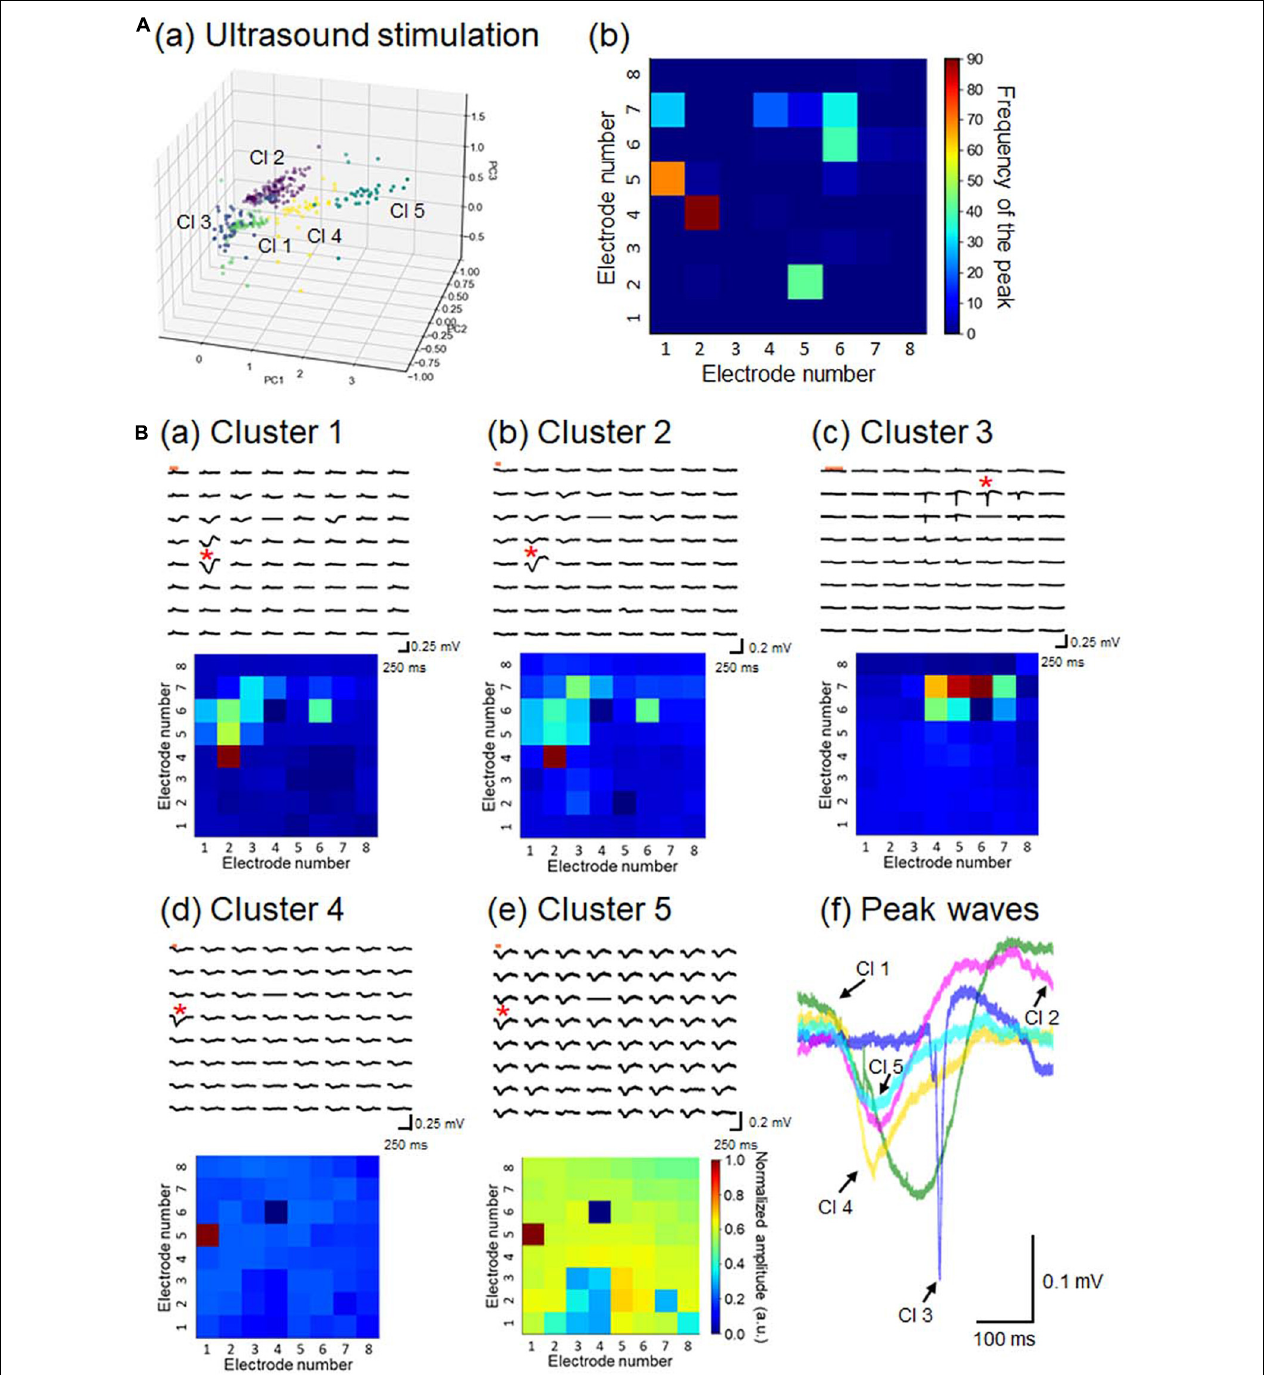
FIGURE 10 | Properties of LFP response patterns for ultrasound stimulation and pattern classification. (A) A total of 351 LFP patterns were converted into pattern vectors a p . These vectors were plotted in 3D space for three major components, calculated using the standard PCA in (a). The vectors were classified into five clusters, labeled Cl 1 to Cl 5. In (b), for each response pattern, the number of sites with a maximum amplitude at a negative peak was counted and accumulated on a 2D electrode array. The colormap represents the frequency of the maximum amplitude sites among the 64 electrode sites. (B) For each cluster, a typical LFP response (upper) and its corresponding pattern matrix (lower), with elements representing the peak amplitudes, are illustrated in (a) to (e), as in Figure 7B . In (f), for a typical response pattern for each cluster, an LFP response waveform with the maximum amplitude is superimposed for all 5 clusters. The selected electrode sites are indicated by red asterisks in the LFP response plots.